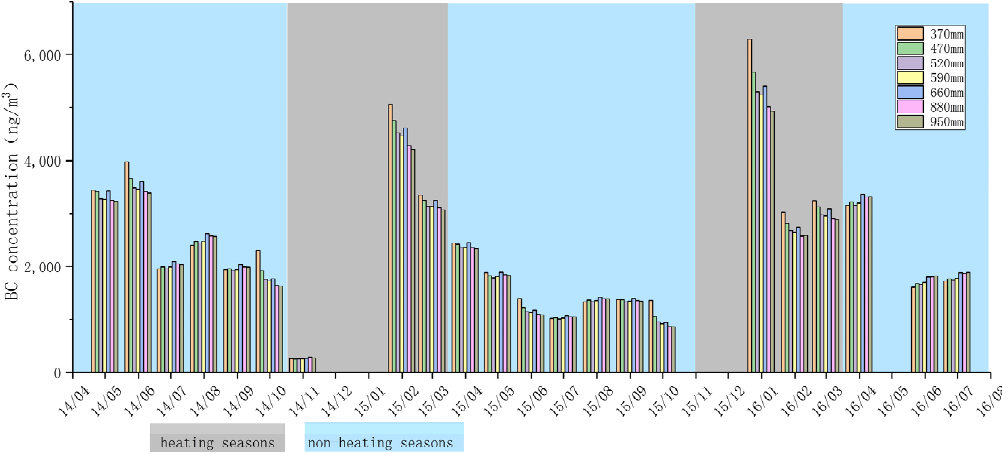
Figure 3. Comparison of EBC concentrations between the heating season and nonheating season. To ensure the representa- tiveness of the daily average, only the months with at least 15 effective days are